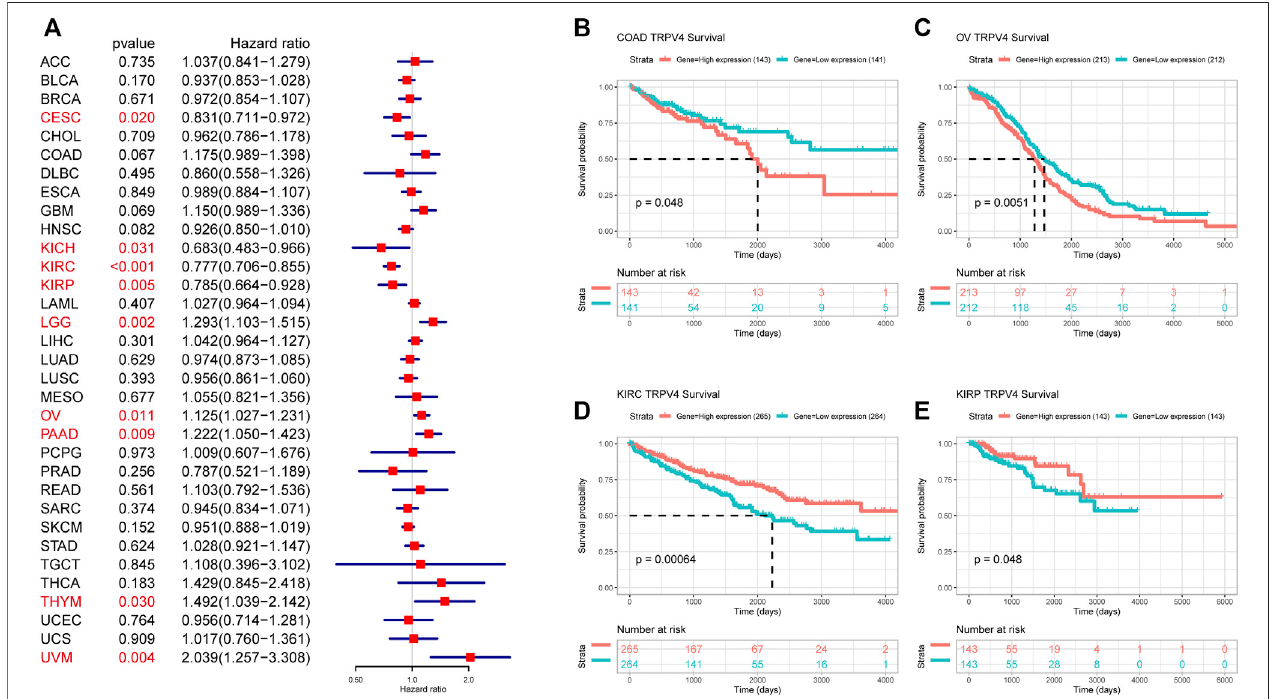
FIGURE 4 | OS analysis of TRPV4 in pan-cancer. (A) Forest map shows the univariate Cox regression analysis results for TRPV4 in TCGA pan-cancer samples. Red indicates signi fi cant results. (B) Kaplan-Meier survival analysis results for TRPV4 in indicated tumor types. The median values of TRPV4 in COAD, OV, KIRC, and KIRP were respectively -0.6416, 0.9493, 3.4129, and 2.4479.